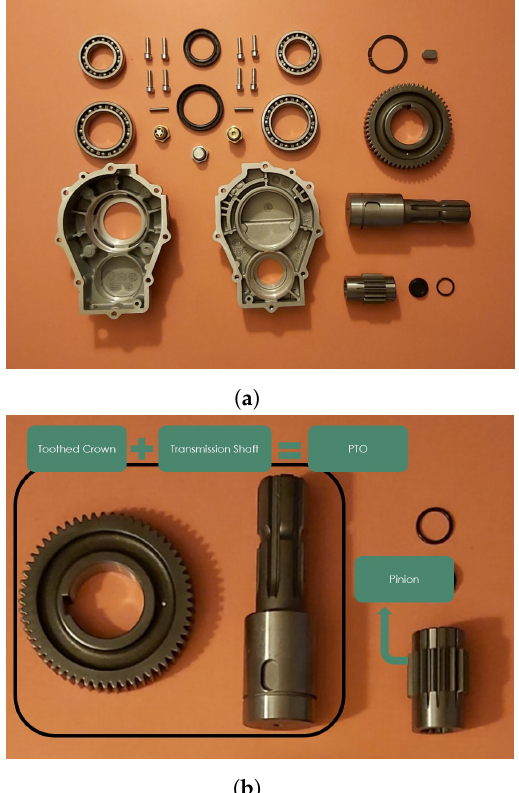
Figure 1. An overview of the product components ( a ). In ( b ), From the right: toothed crown, transmission shaft, and pinion. The toothed crown and the transmission shaft are coupled by interference, composing the power-take-off